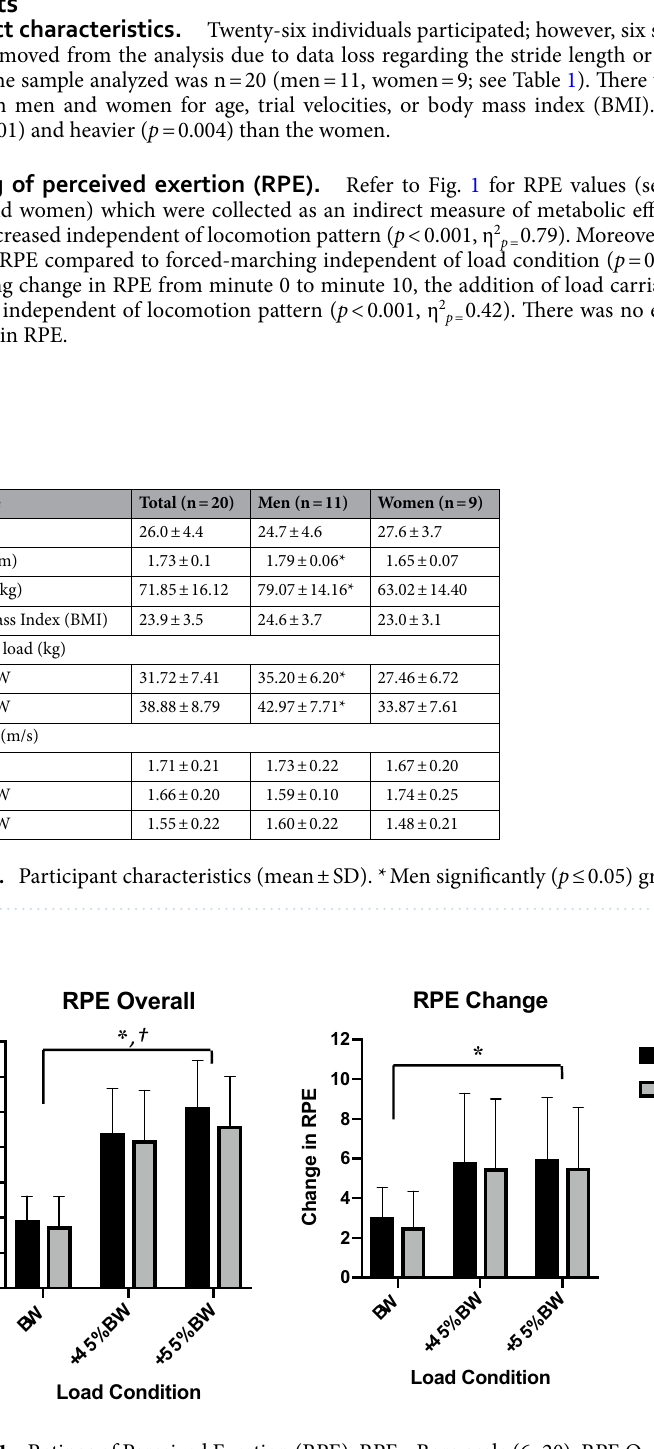
Figure 1. Ratings of Perceived Exertion (RPE). RPE = Borg scale (6–20); RPE Overall represent RPE of the entire trial; Change in RPE calculated as the final RPE value subtracting the first RPE value. * = Significant main effect of load; † = Significant main effect of locomotion